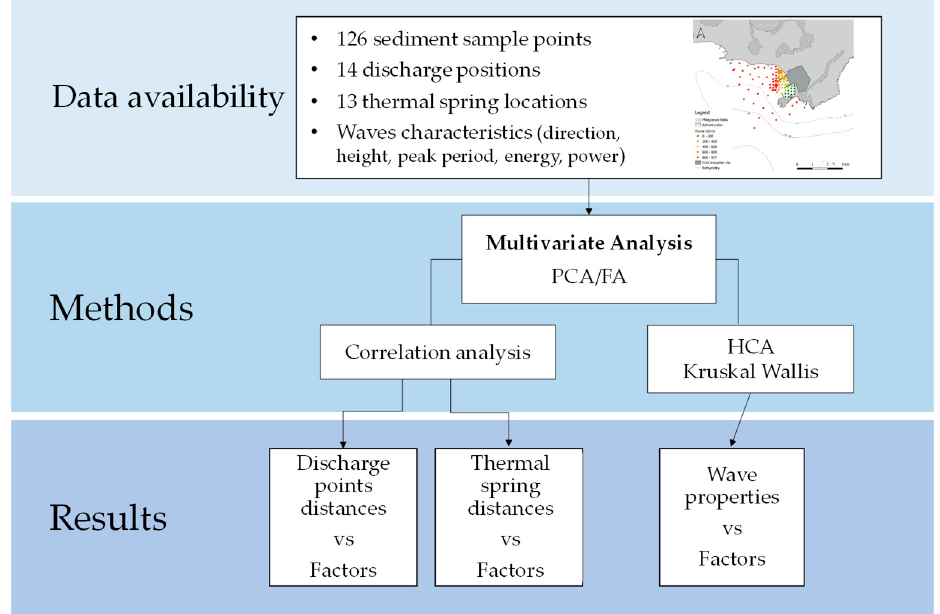
Figure 1. Workflow scheme of the study. This work basically generates three main results boxes: the first and the second box include bivariate correlations analysis, respectively between PC/Fs and distances from sewage discharge and PC/Fs and distances from thermal spring, while the third box includes the hierarchical cluster analysis (HCA) and Kruskal Wallis test.